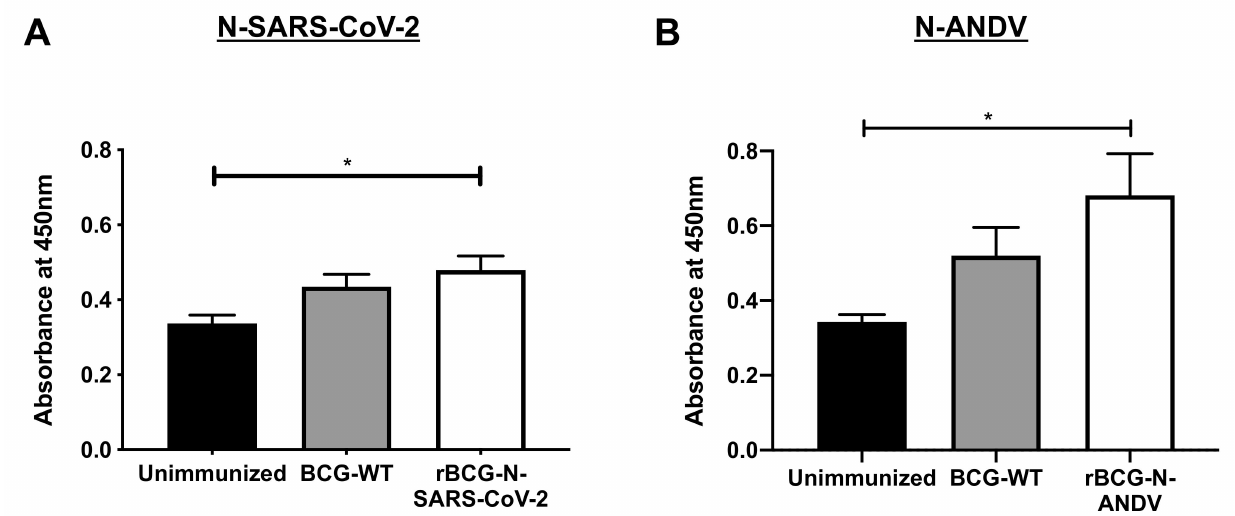
Figure 6. Determination of specific antibodies induced by immunization with the recombinant BCGs. ELISAs were performed to measure total antibodies against the nucleoproteins in samples collected on day 24 post-immunization (rBCG-N-SARS-CoV-2) ( A ) or 28 post-immunization (rBCG-N-ANDV) ( B ). Data are representative of 3 independent experiments. Each experiment considered a total of three mice per group. Statistical differences were assessed by Kruskal–Wallis test with a post hoc Dunn’s test. *: p <